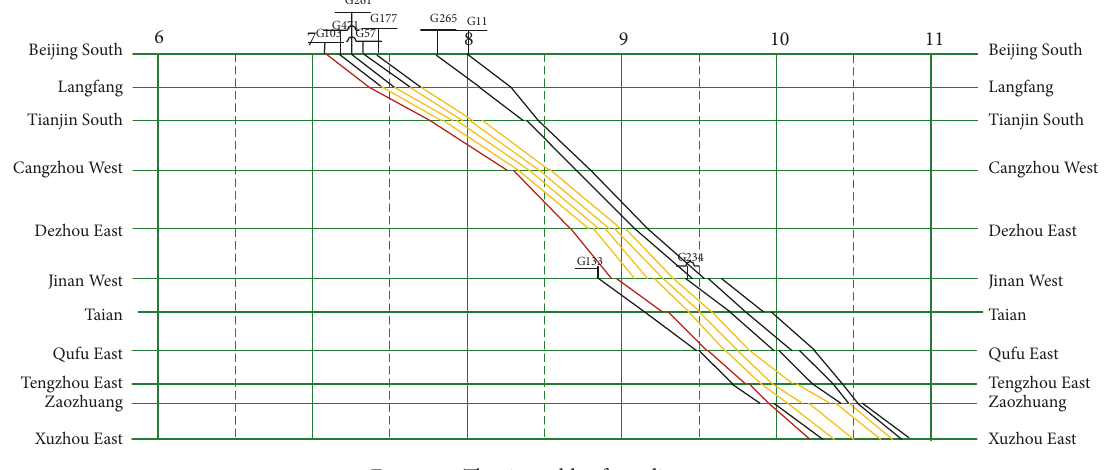
Figure 7: The timetable after adjustment.